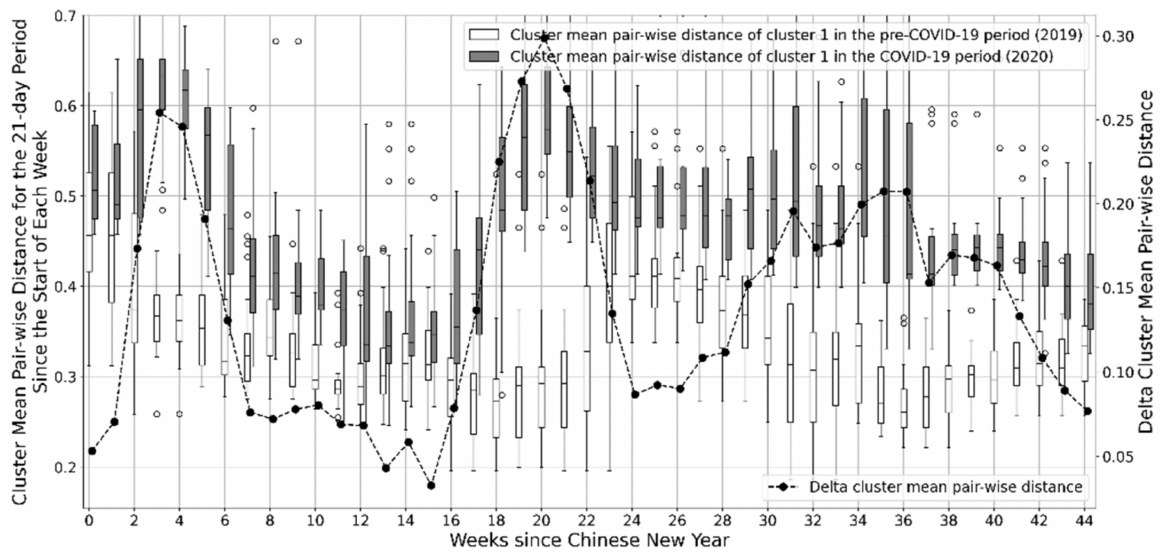
Figure 10. Boxplot comparison of the cluster mean pairwise distance of cluster 1 between the COVID-19 period and the pre-COVID-19 period (each green or blue boxplot represents the cluster mean pairwise distance for the 21-day period from the indicated week on the x -axis; delta cluster mean pairwise distance is the difference between the cluster mean pairwise distance of the COVID-19 period and the pre-COVID-19